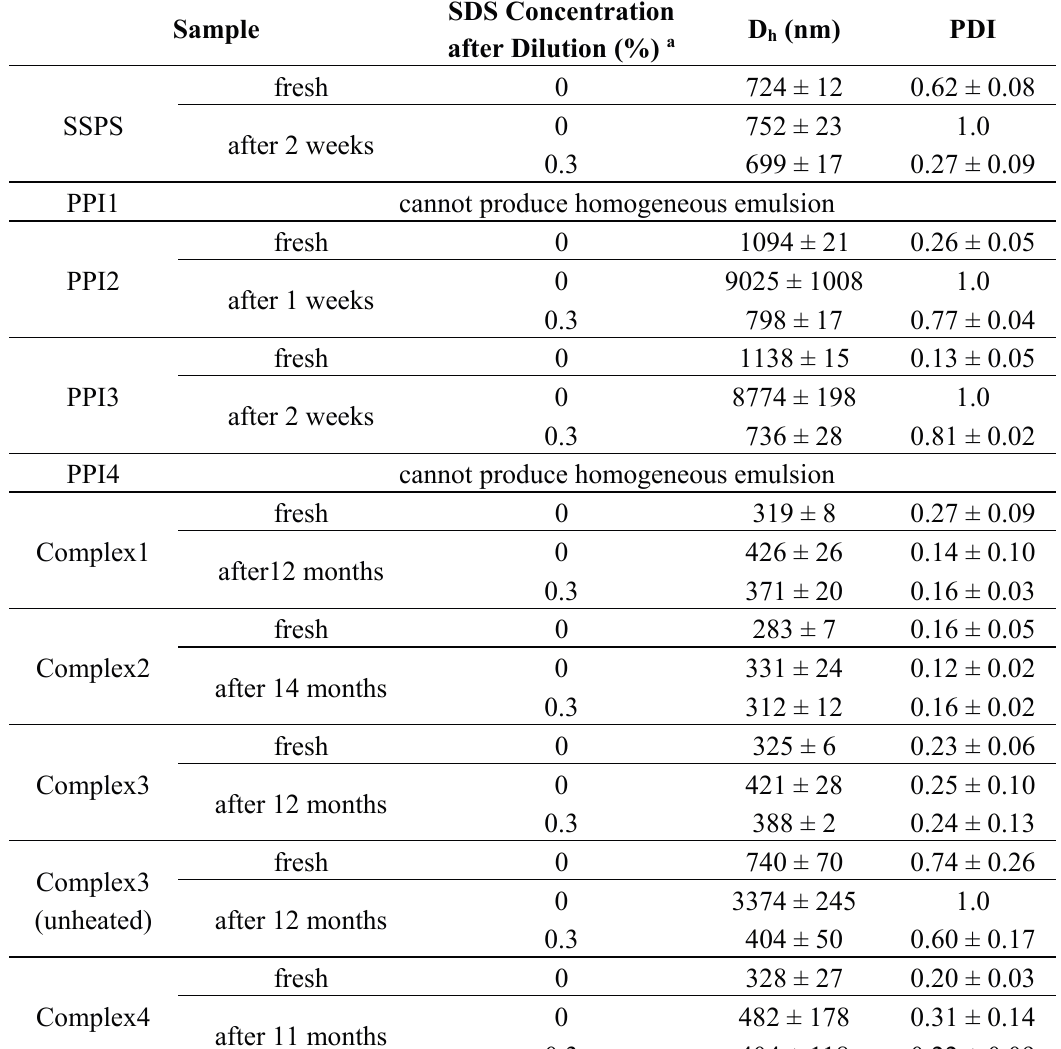
Table 3. DLS results of PPI, SSPS, and complex emulsions before and after long-term storage in pH 6 with 0.2 M NaCl at 4